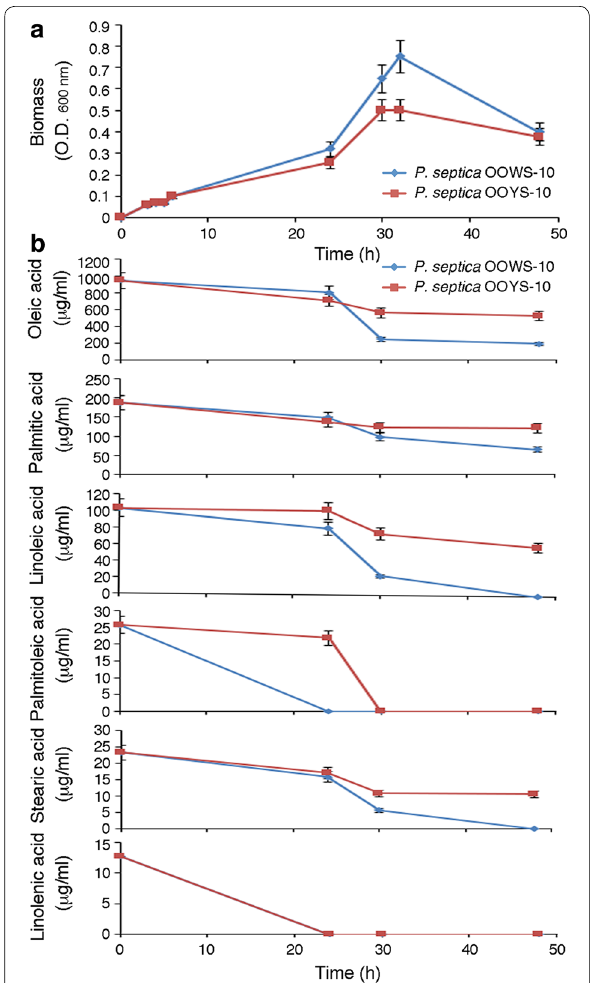
Fig. 5 Growth curves of P. septica isolates OOWS-10 and OOYS-10 in M9-OO medium ( a ) and microbial utilization of Alài ® extra-virgin olive oil fatty acids as determined by GC–MS ( b